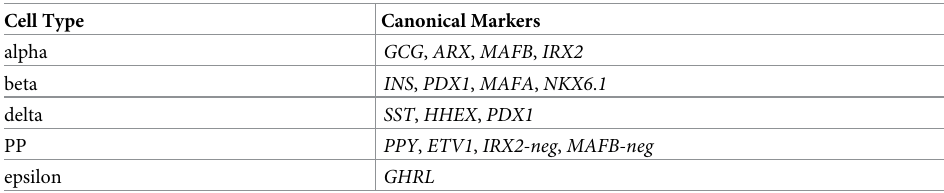
Table 2. Canonical islet cell markers used to annotate cell